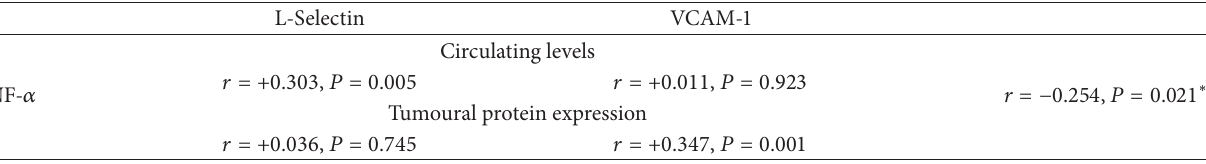
Table 6: Correlation of TNF- 𝛼 with L-Selectin and VCAM-1 in PTC patients.